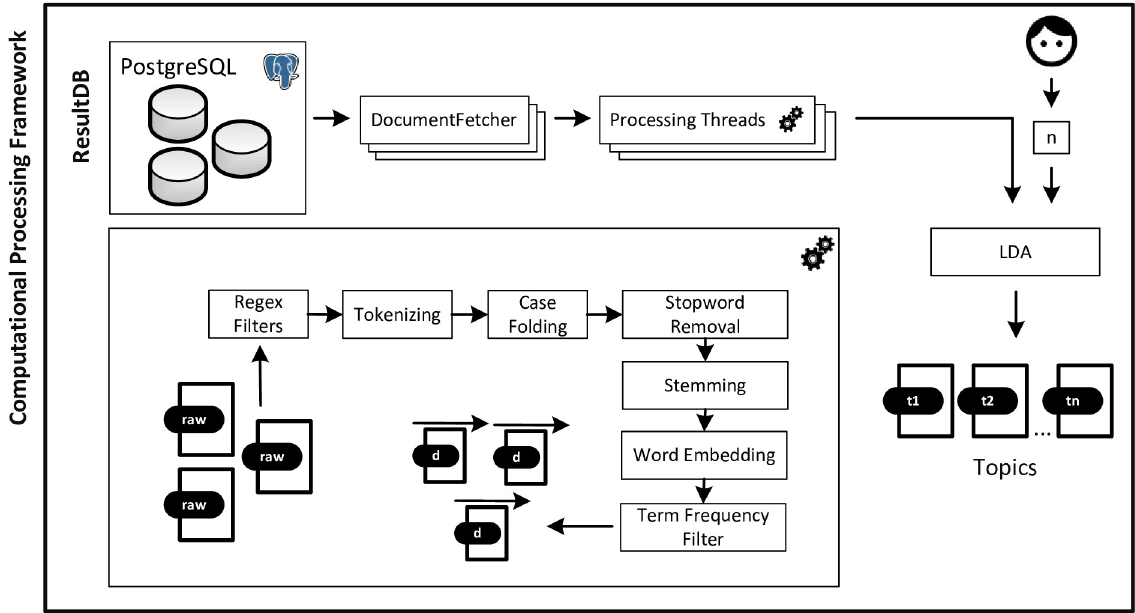
Fig 2. Workflow of the processing steps and software components for topic modeling: (1) text material is retrieved from a central relational database; (2) several processing threads perform a collection of pre-processing tasks; (3) LDA is applied to the resulting document vectors. The software takes raw text material as an input and outputs n topics. The n is a user-defined input parameter to LDA.